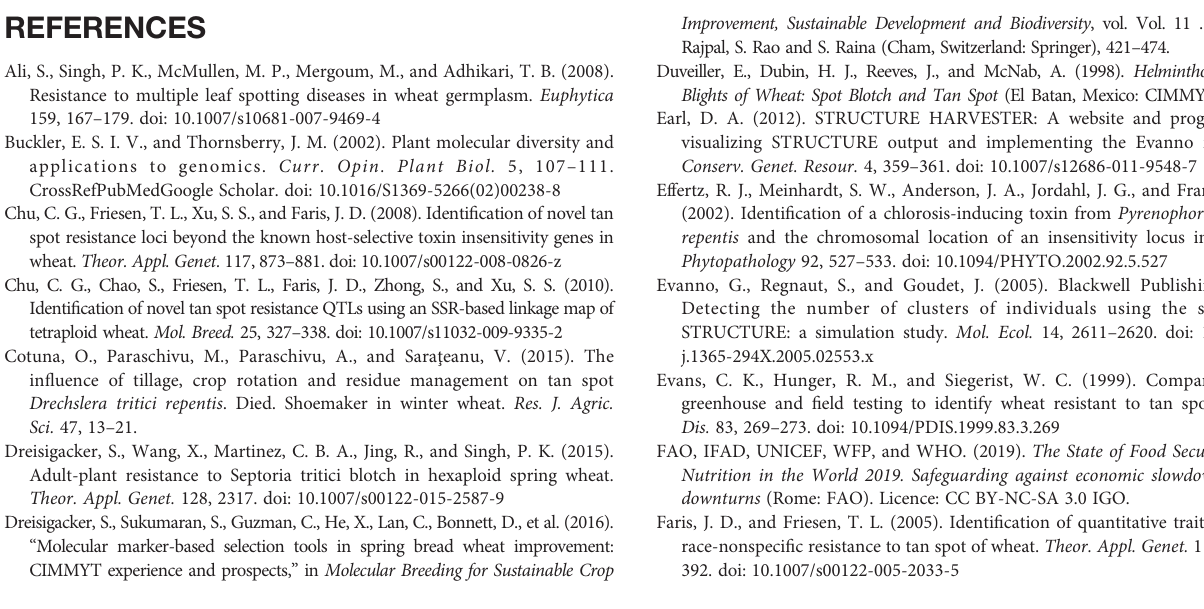
SUPPLEMENTARY TABLE 1 | Pedigree details of 184 spring wheat genotypes used for GWAS of Tan